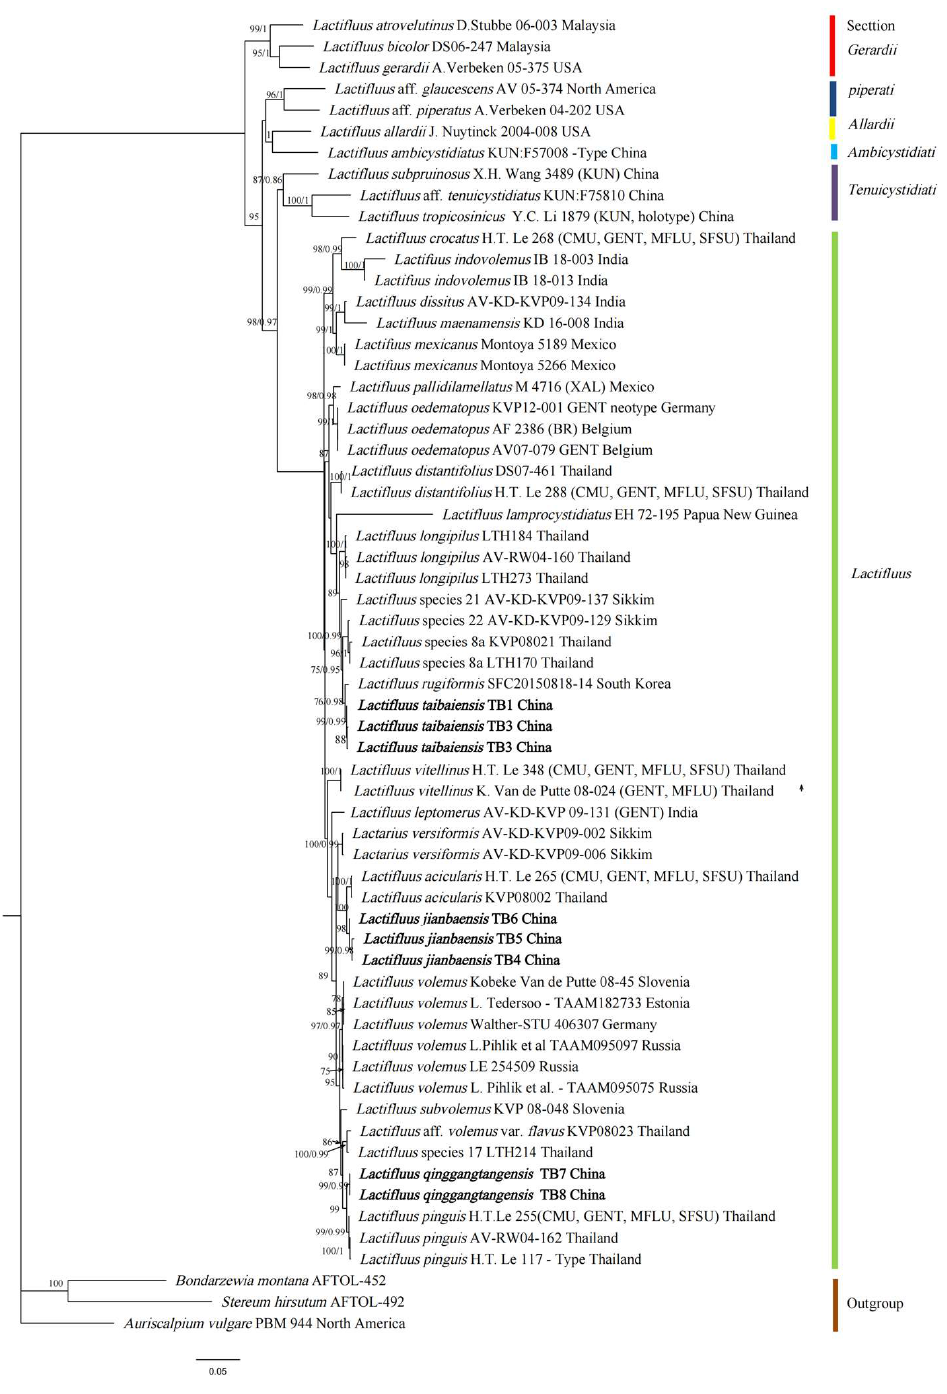
Figure 1. Phylogram for Lactifluus sect. Lactifluus generated from maximum likelihood analysis of ITS, LSU, and RPB2 sequence data. Bootstrap support values for maximum likelihood and maximum parsimony greater than 50% and posterior probabilities from Bayesian inference ≥ 0.95 are given above the branches. The new species are presented in bold